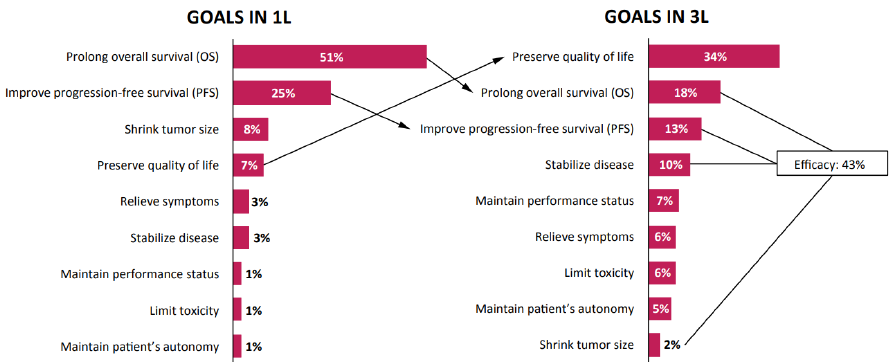
Figure 2. Treatment goals in the first-(1L) and third-line (3L) settings.